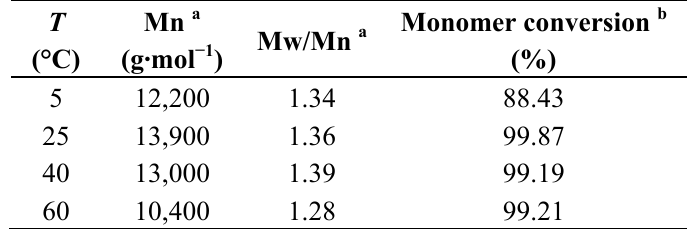
Table 3. Effects of Temperature on the Polymerization of